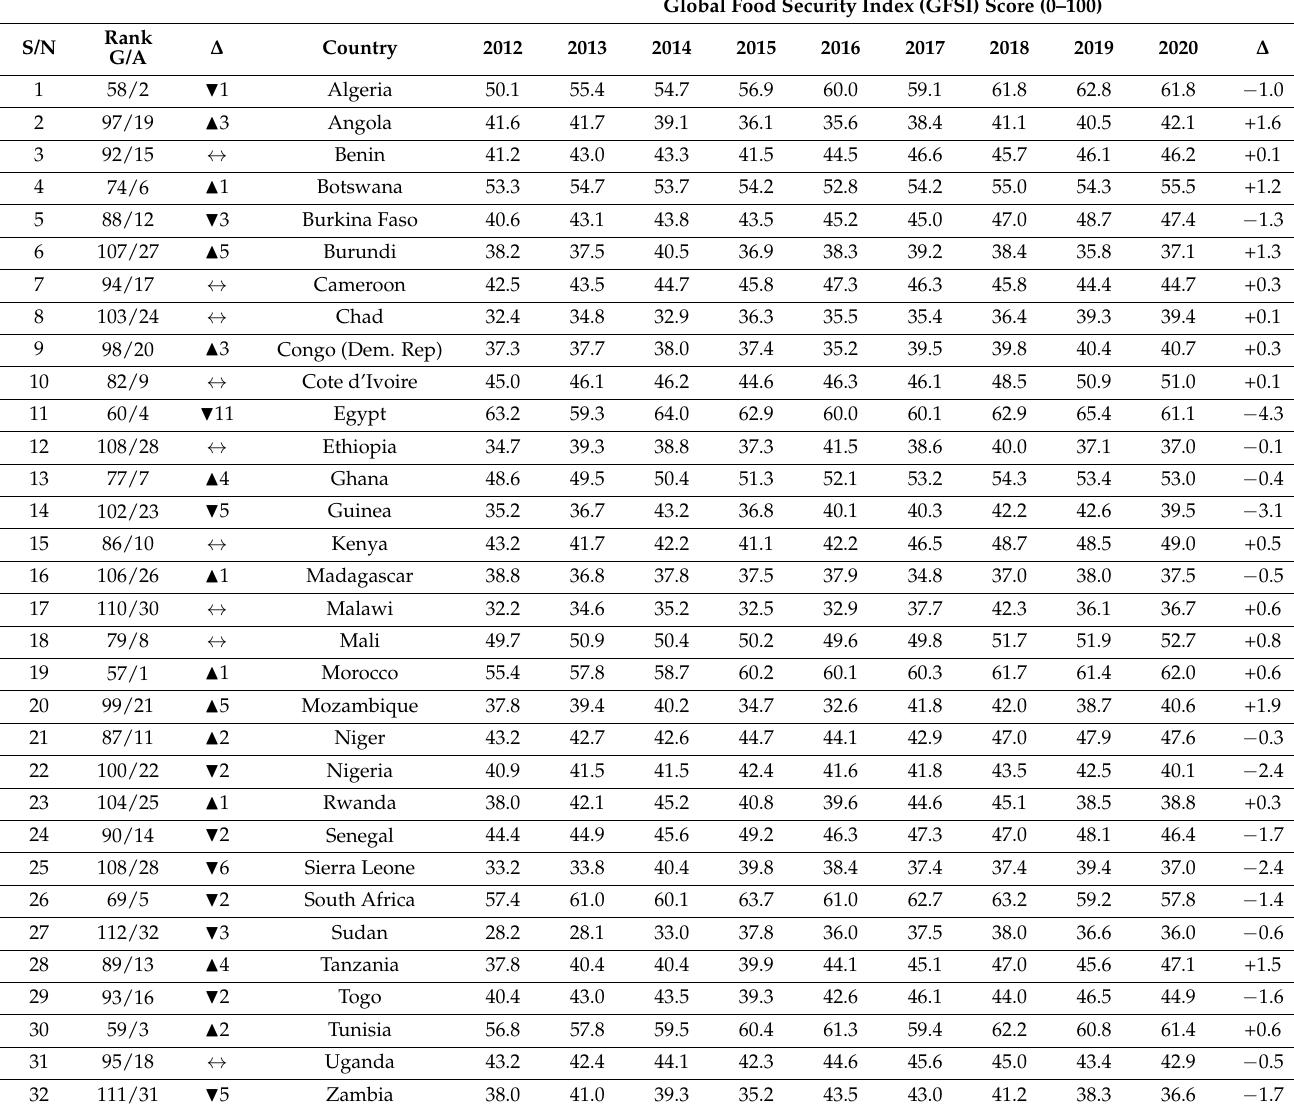
Table 1. Global Food Security Index (GFSI) Score (2012–2020) African countries. Source: author’s compilation using 2012–2020 Global Food Security Index scores (African countries exported) EIU, 2021; Rank G/A means global/Africa rank; global rank from 113 countries; Africa rank from 32 countries Note: ∆ = change in score/rank, comparing 2020 with 2019; (cid:78) = rank progressed; (cid:72) = rank declined; ↔ = No change in